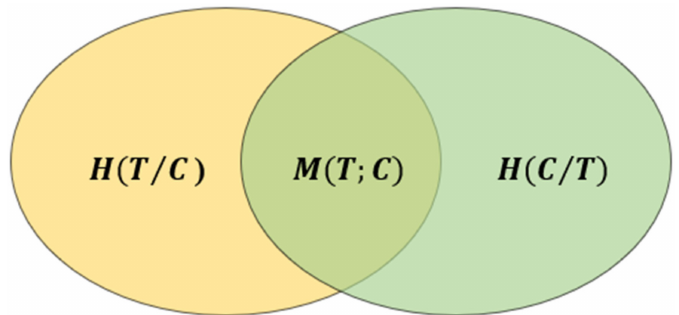
Figure 3. The relationship of information entropy between images T and C .